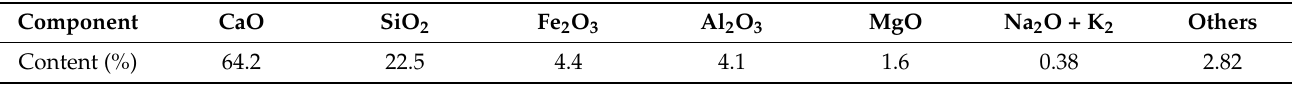
Table 1. Chemical composition of oil well